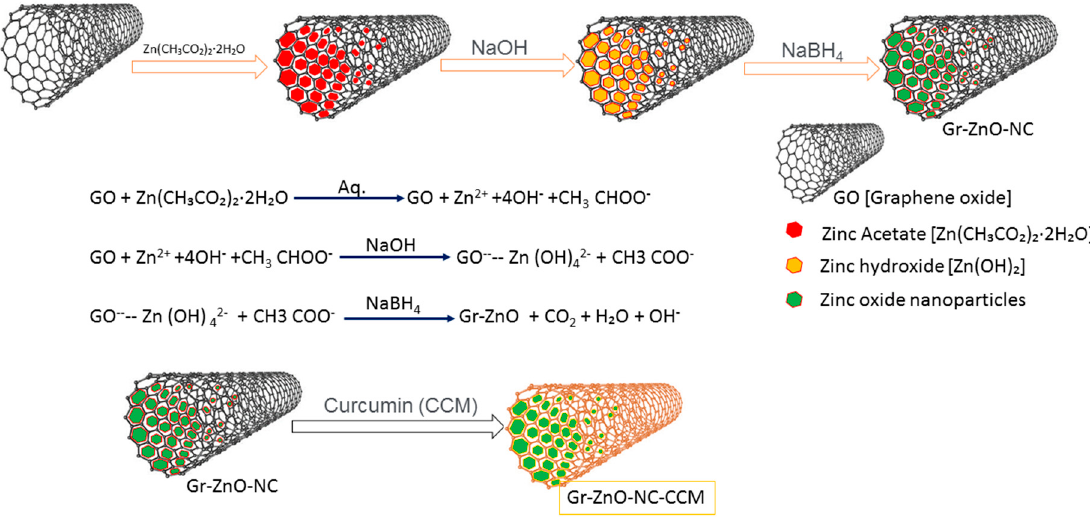
Figure 1. Schematic representation of GrZnO-NCs synthesis by Hummer’s method.